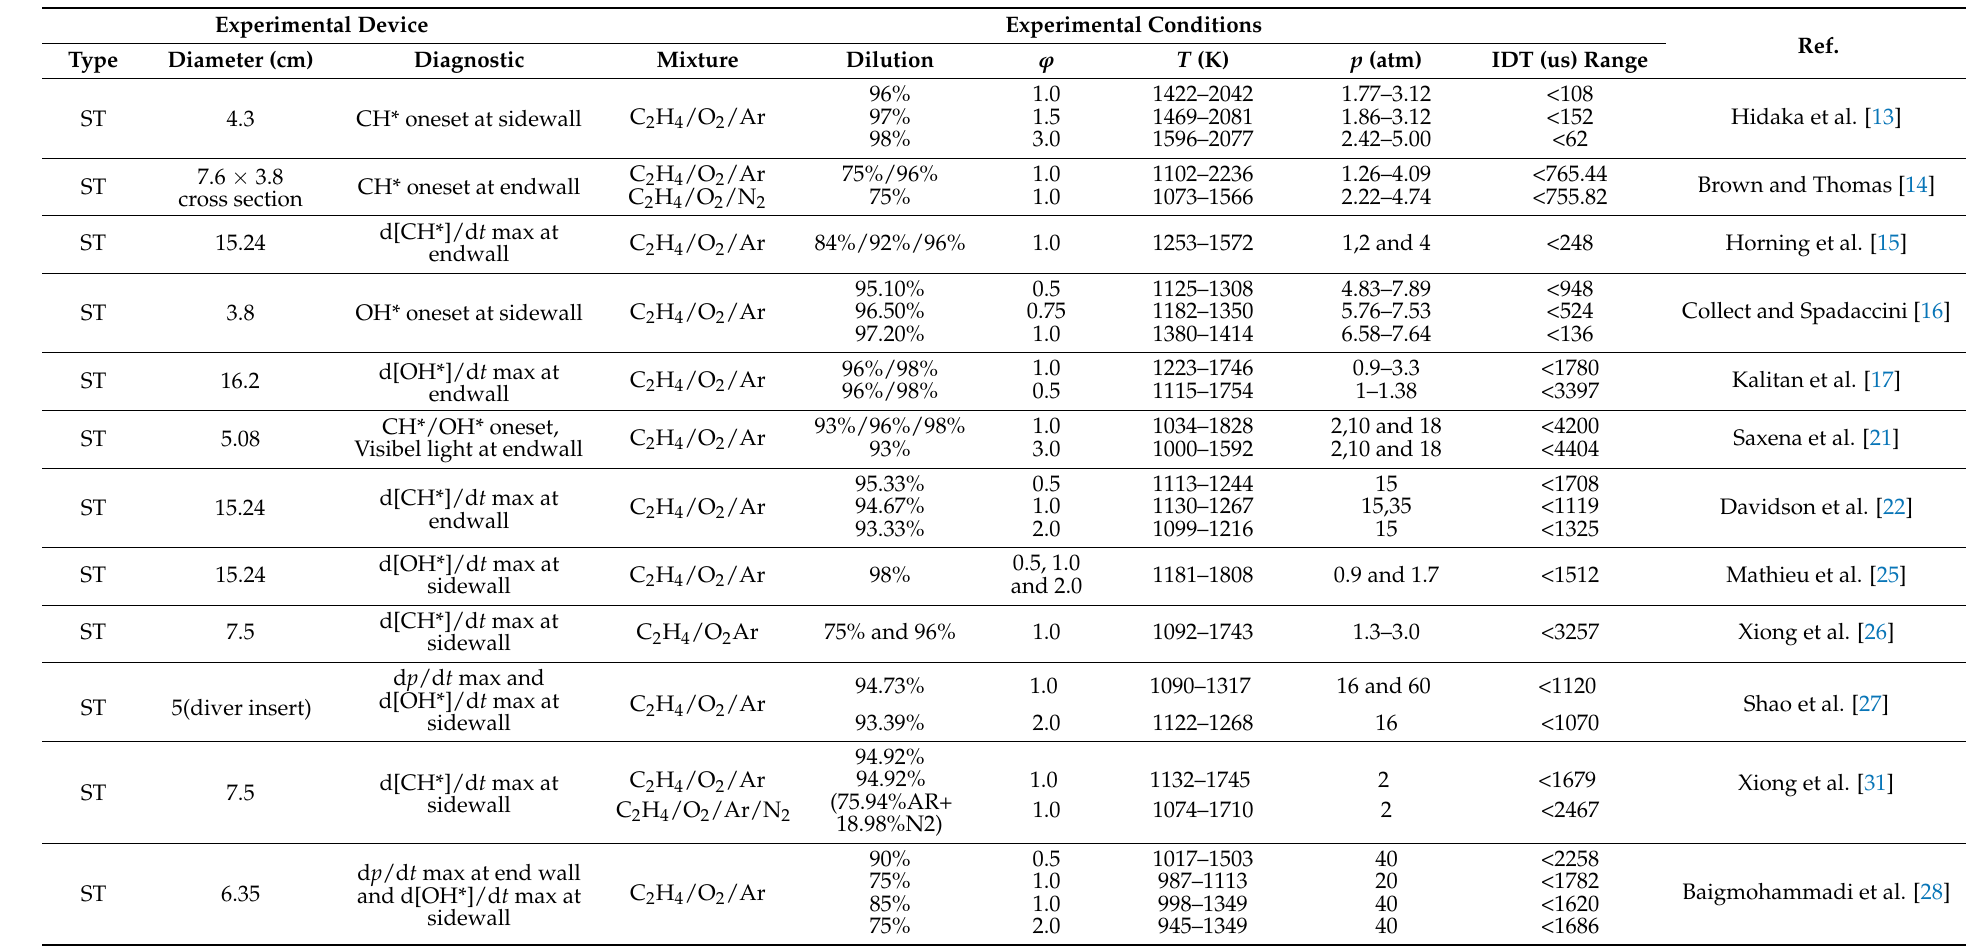
Table 2. Ignition delay time studies of C 2 –C 4